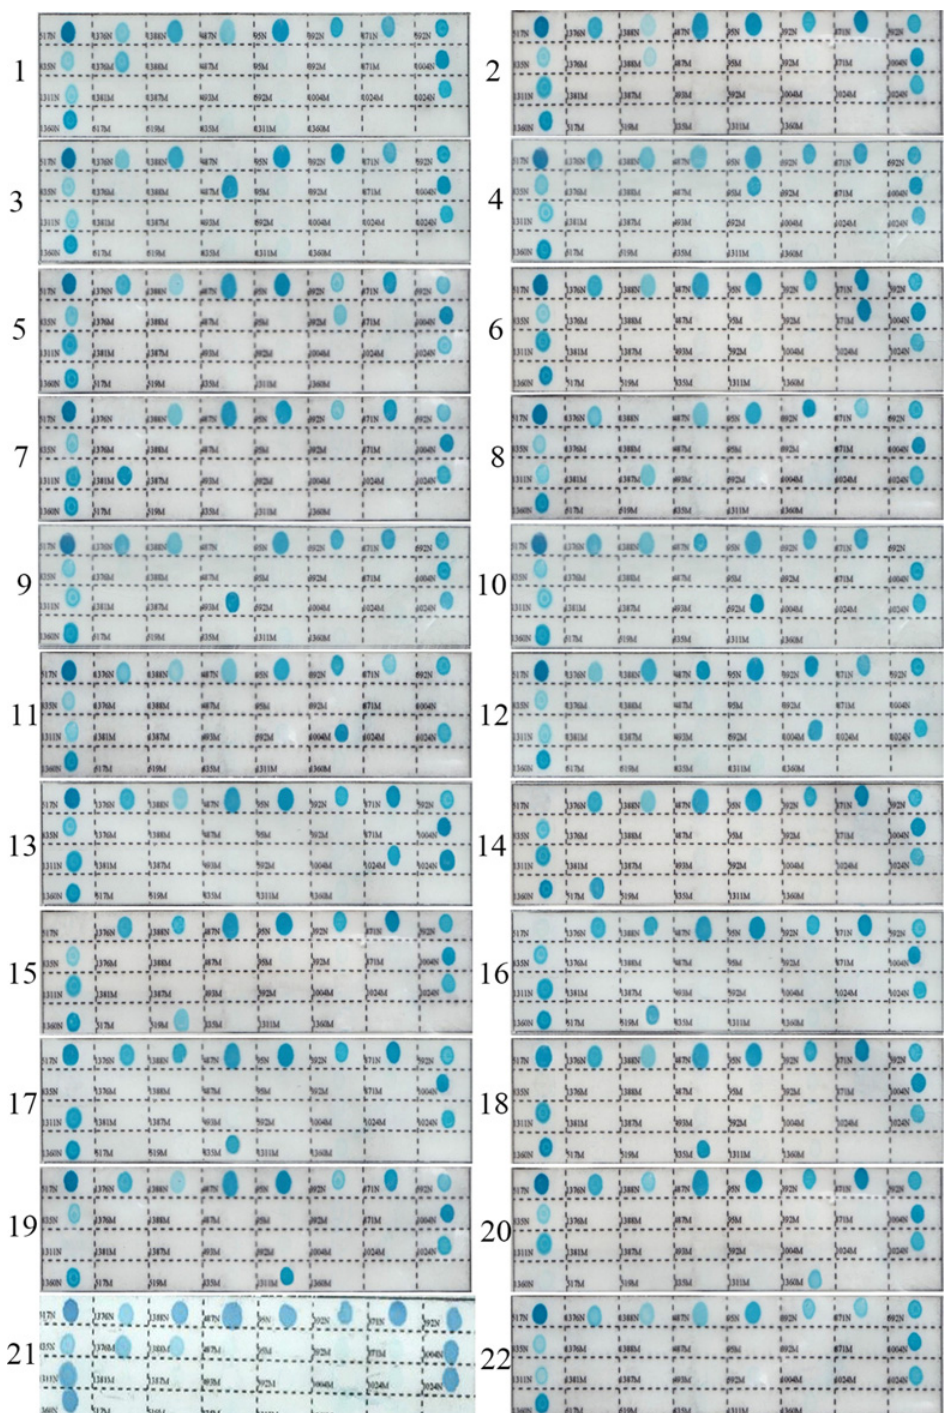
Fig 2. Representative genotyping results of G6PD deficiency using reverse dot blot assay. (1)c.1376 G > T heterozygotes;(2) c.1388 G > A heterozygotes; (3)c.487 G > A Hemizygote; (4)c.95 A > G heterozygotes; (5)c.392 G > T heterozygotes; (6)c.871 G > A heterozygotes; (7)c.1381 G > A Hemizygote; (8)c.1387 C > A Hemizygote; (9)c.493 A > G Hemizygote; (10)c.592 C > T Hemizygote; (11)c.1004 C > T Hemizygote; (12)c.1004 C > A Hemizygote; (13)c.1024 G > T heterozygotes; (14)c.517 T > C Hemizygote; (15)c.519 C > G Hemizygote; (16)c.519 C > T Hemizygote; (17)c.835 A > G Hemizygote; (18)c.835 A > T Hemizygote; (19)c.1311 C > T Hemizygote; (20)c.1360 C > T Hemizygote. (21)c.1376 G > T/c.1388 G > A double heter-ozygotes (22) normal control.